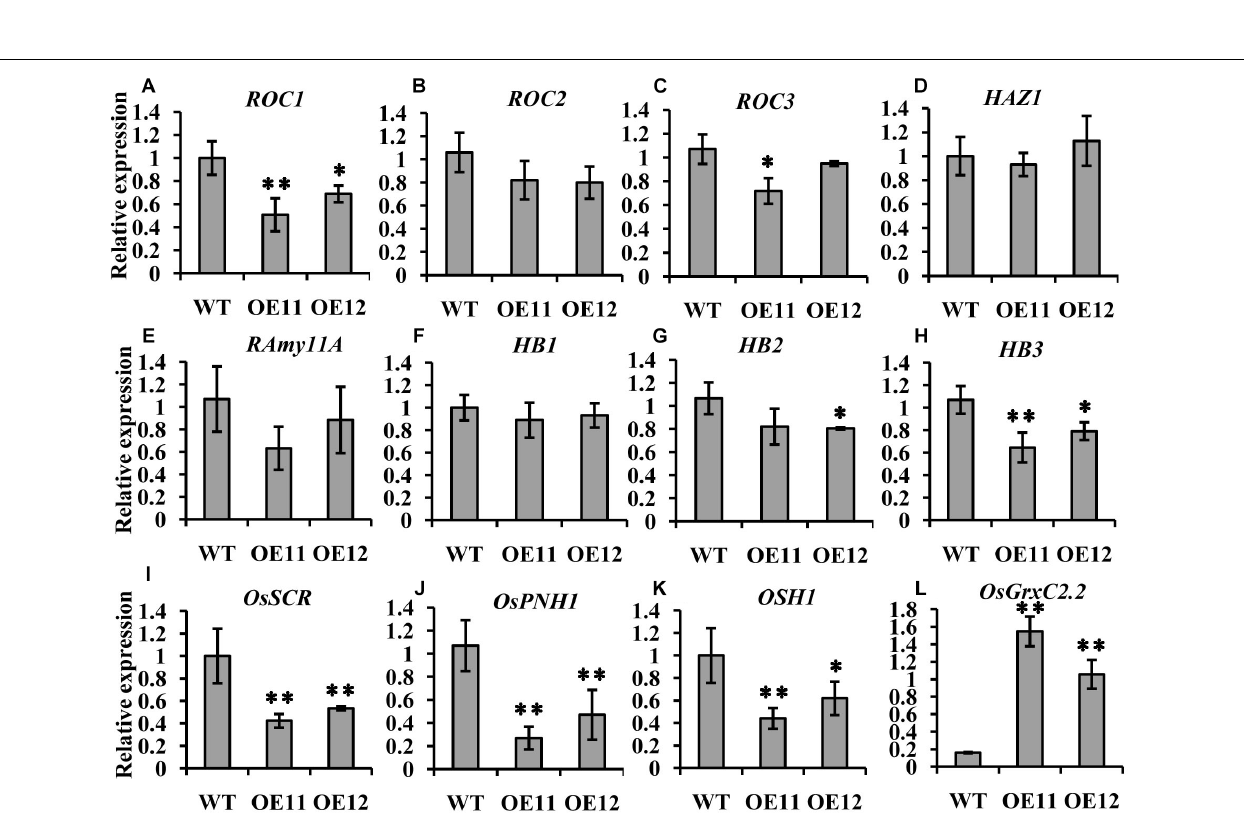
Frontiers in Plant Science |